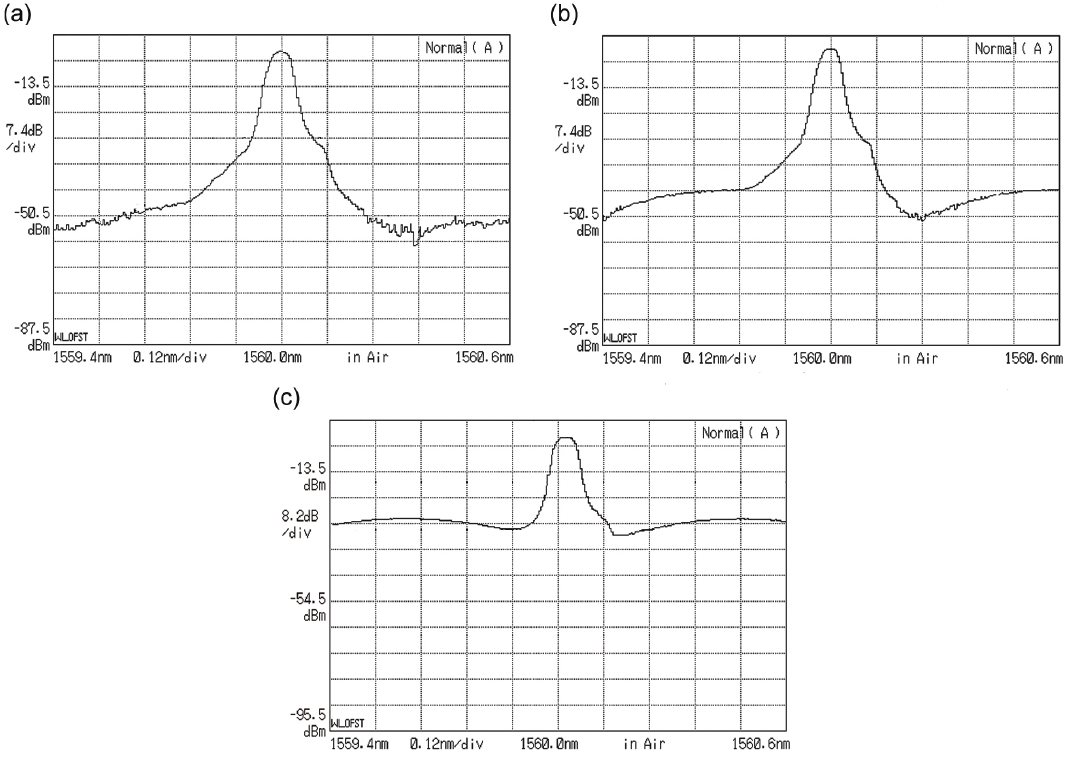
Figure 13. Optical spectrum at 4 Gb/s of ( a ) RSOA output, ( b ) BFL output at transparency, ∆ λ = 0 nm, ( c ) BFL output for detuning ∆ λ = − 0.05